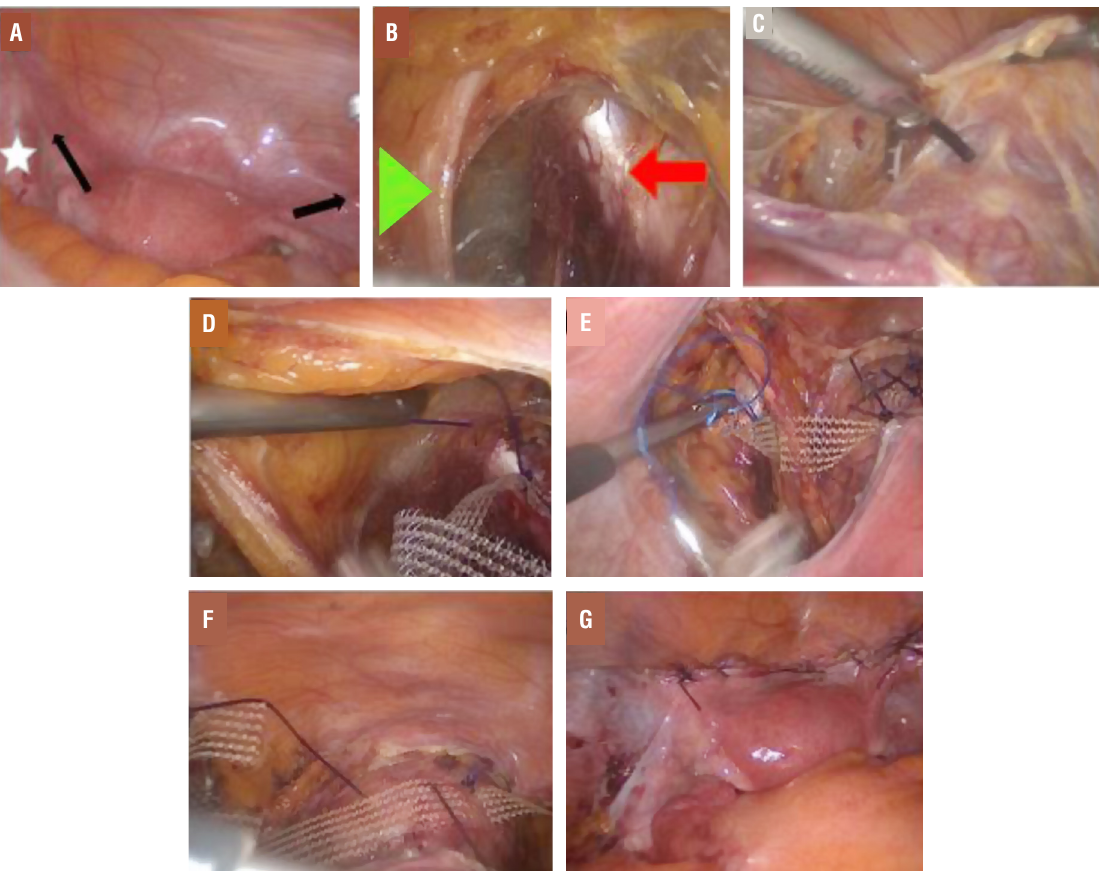
Figure 2 - Intraoperative